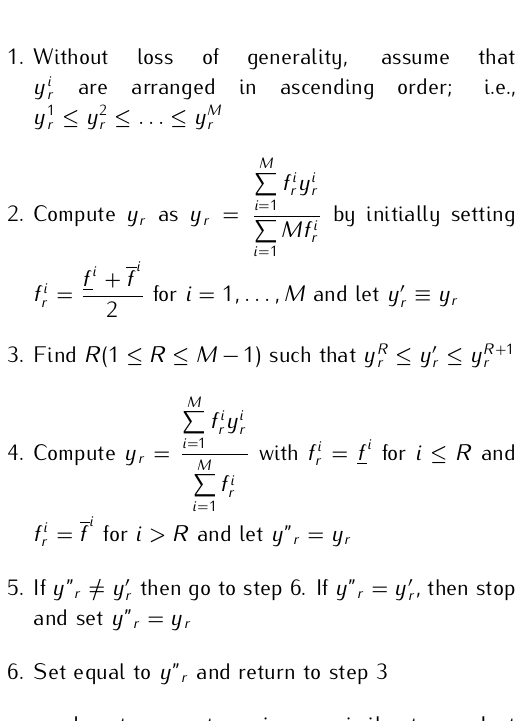
Figure 5. Structure of type-2 fuzzy logic system